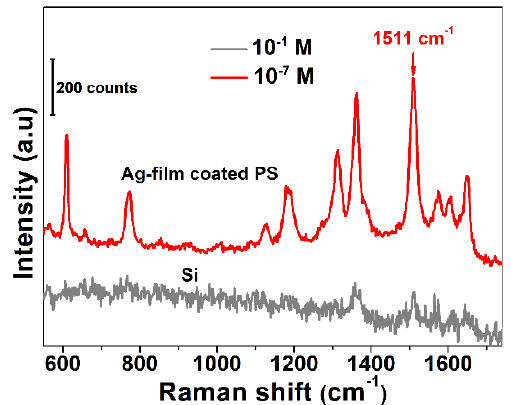
Figure 4. Raman spectrum of R6G with concentrations of 10 − 7 M and 10 − 1 M absorbed on the SERS substrate (red curve) and the silicon wafer (black curve), respectively.